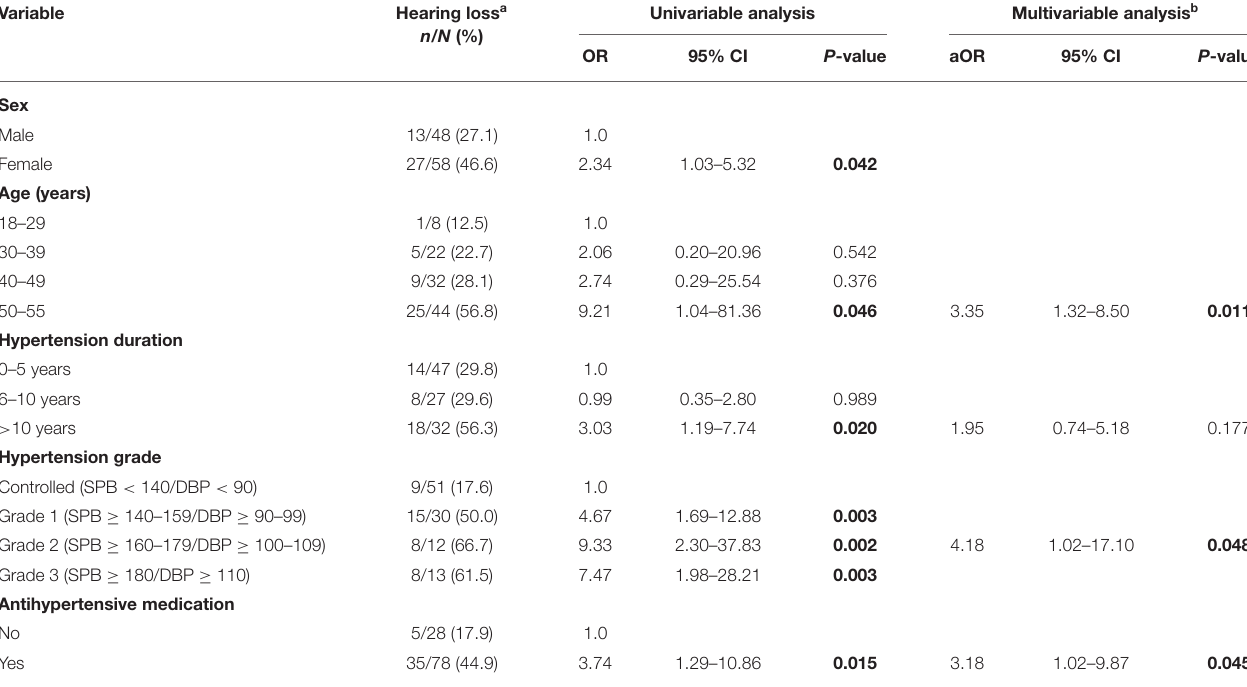
TABLE 4 | Univariate and multivariate logistic regression analysis of factors associated with hearing loss among hypertensives.